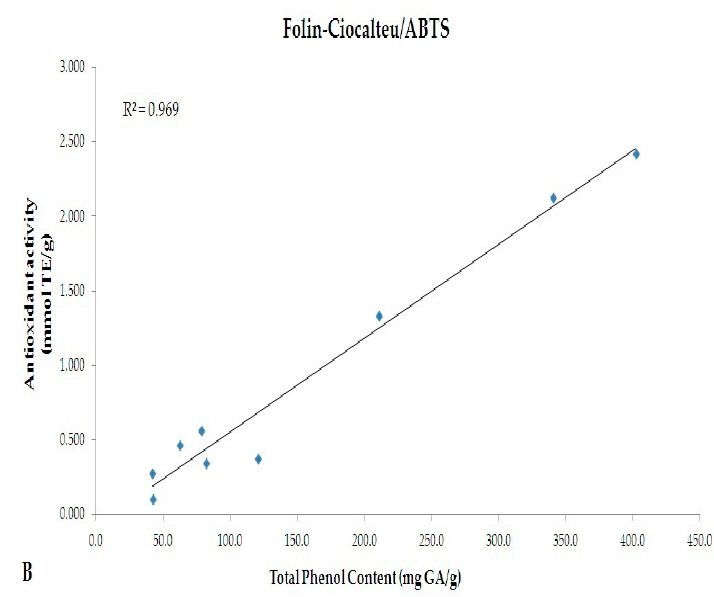
Figure 4. Linear correlation between TPC evaluated by Folin-Ciocalteu (mg GA/g) and antioxidant activity (mmol TE/g) evaluated by ( A ) DPPH and ( B ) ABTS methods.